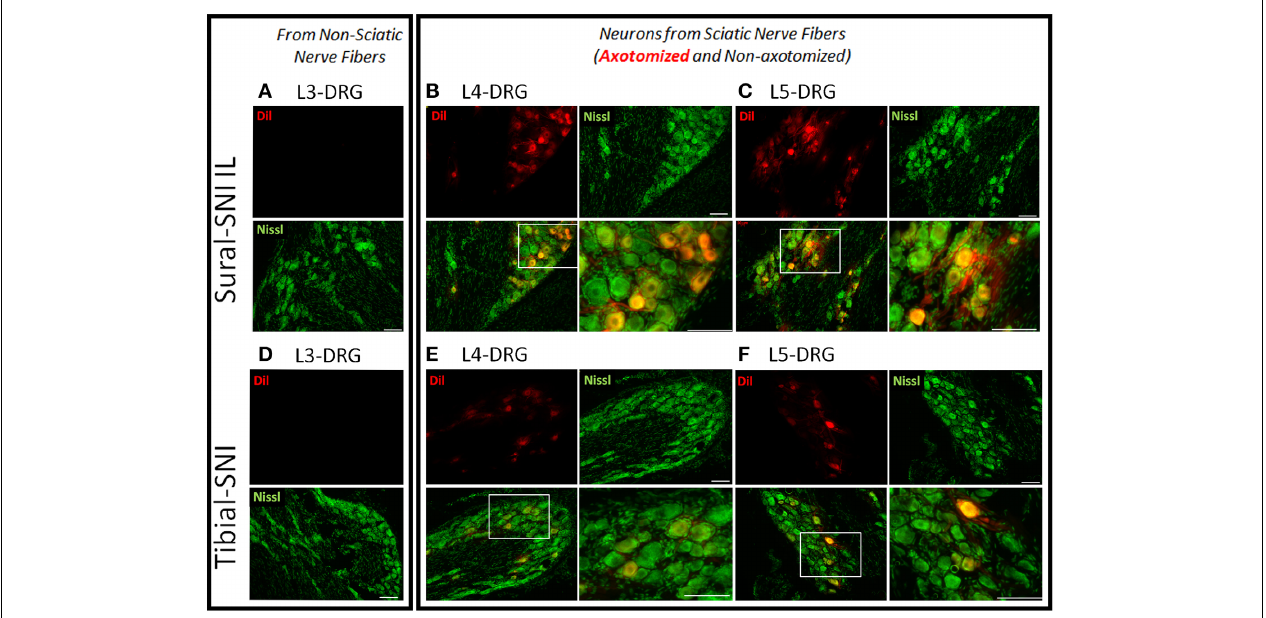
FIGURE 2 | Labeling of injured neurons. Images of DRG sections from ipsilateral L3-, L4-, and L5-DRG derived from Sural-SNI (A–C) and Tibial-SNI (D–F) . Sensory neurons are labeled with Nissl (green) and injured sensory neurons are labeled with Dil (red). Sensory neurons of various sizes are